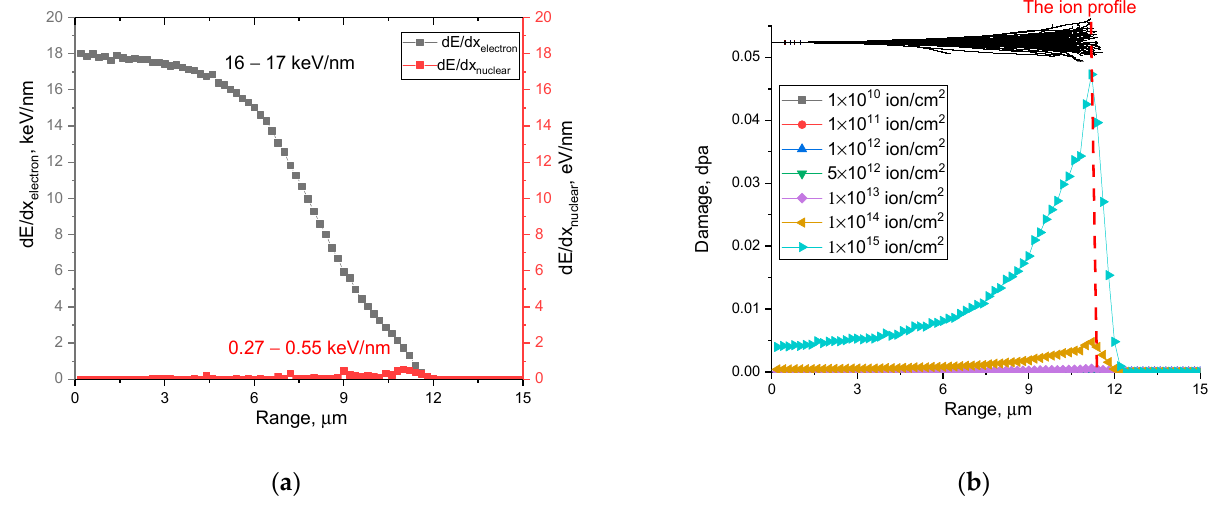
Figure 2. ( a ) Results of simulation of ionization losses of incident Kr 15+ ions with an energy of 147 MeV in a NbTiVZr alloy target with a density of 6.5 g/cm 3 . ( b ) Simulation results of the distribution of atomic displacements along the ion trajectory in the target material.